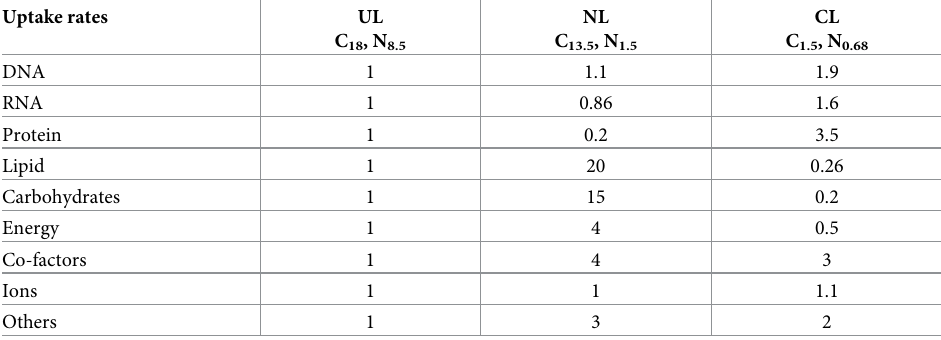
Table 2. The table shows the three environments defined by carbon (C) and nitrogen (N) uptake and the scaling of biomass groups. The groupings are used to scale the containing compounds for the creation of the BOF [17, 21, 39– 45]. For example, we define that protein is scaled by 0.2 in a nitrogen limited environment. Consequently, the factor for each compounds in the protein group is multiplied by the corresponding factor for the new BOF.